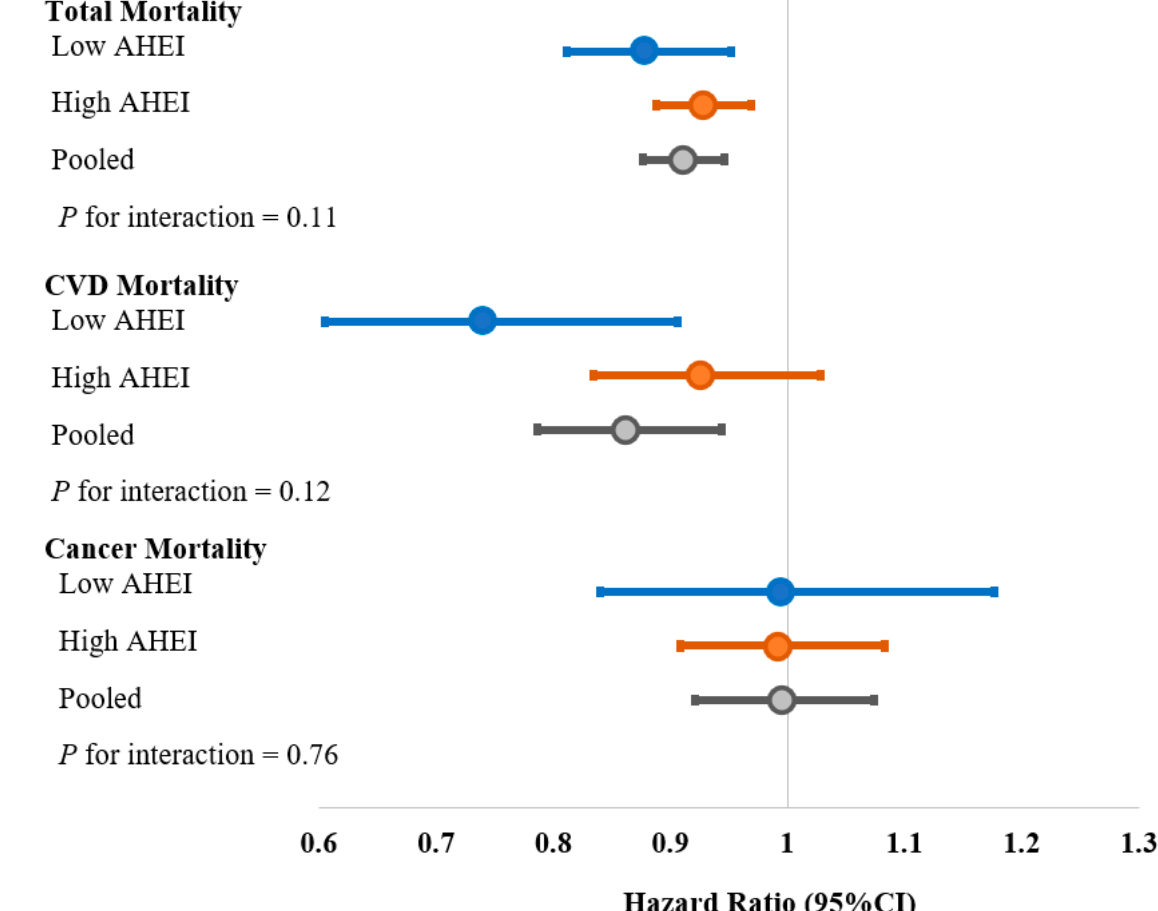
Figure 1. HRs (95% CIs) of total and cause-specific mortality per 0.5 serving increase in walnut consumption stratified by AHEI. Adjusted for covariates updated over time, including: age (continuous), sex, race (Caucasian, yes/no), smoking status (never, past, current 1 to 14 cigarettes/day, current 15 to 24 cigarettes/day, current ≥ 25 cigarettes/day), alcohol consumption (g/day: 0, 1–4.9, 5–14.9, 15–29.9, ≥ 30), physical activity (metabolic equivalent hours/week, <3, 3–8.9, 9–17.9, 18–26.9, ≥ 27), current multivitamin use (yes/no), current aspirin use (yes/no), family history of diabetes mellitus